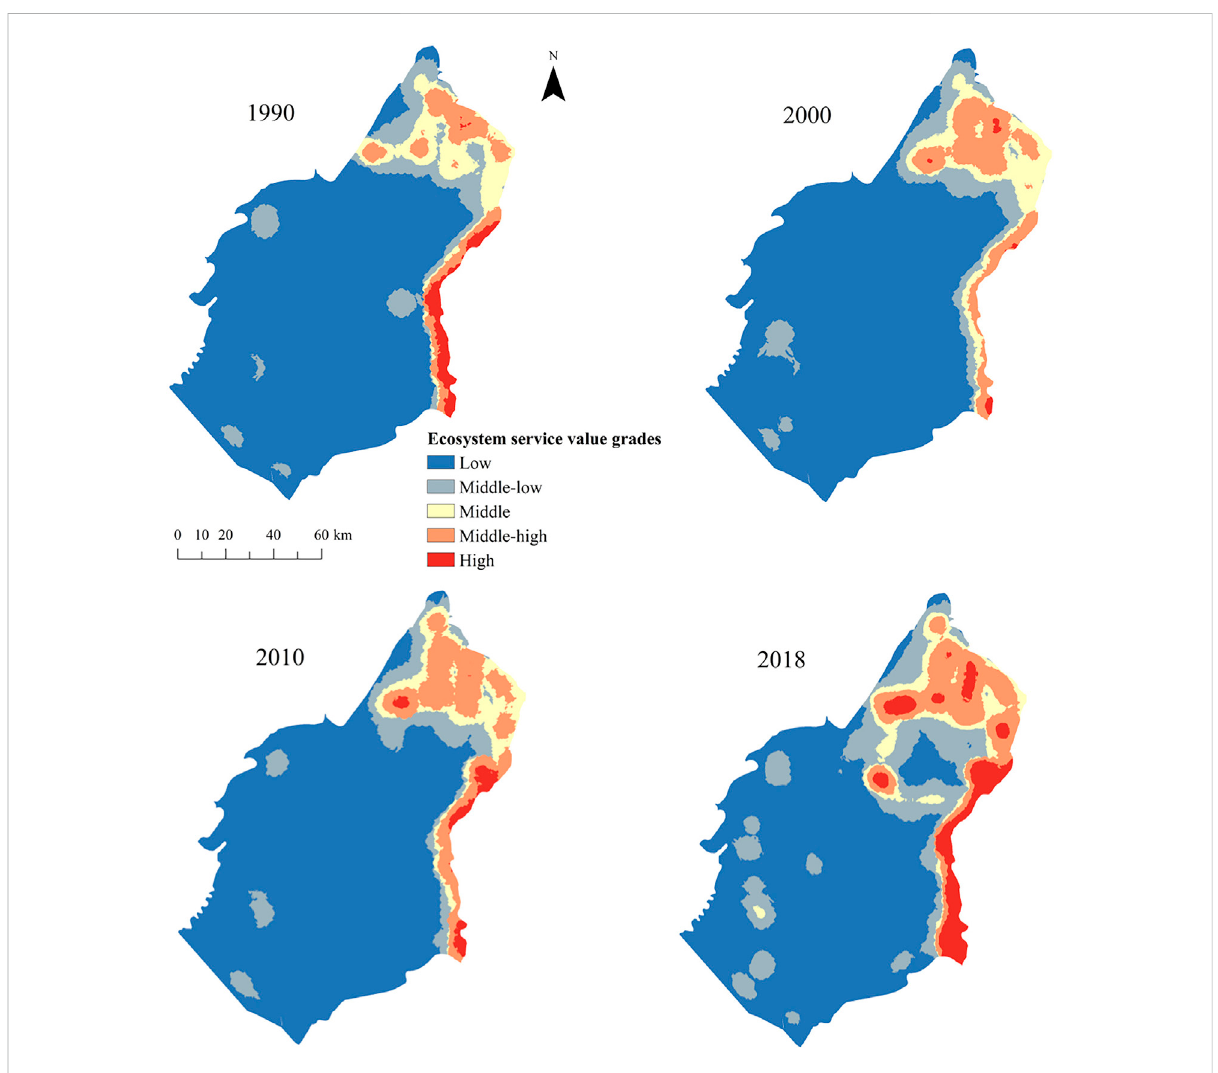
FIGURE 3 Spatial distribution of ESV in the Ulan Buh Desert in 1990 –